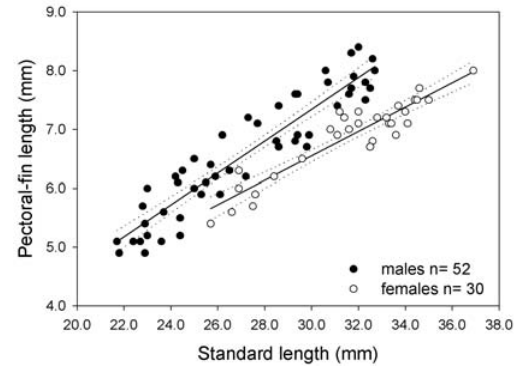
Fig. 8. Pectoral-fin length as a function of standard length for males against females of Odontostilbe pulchra .